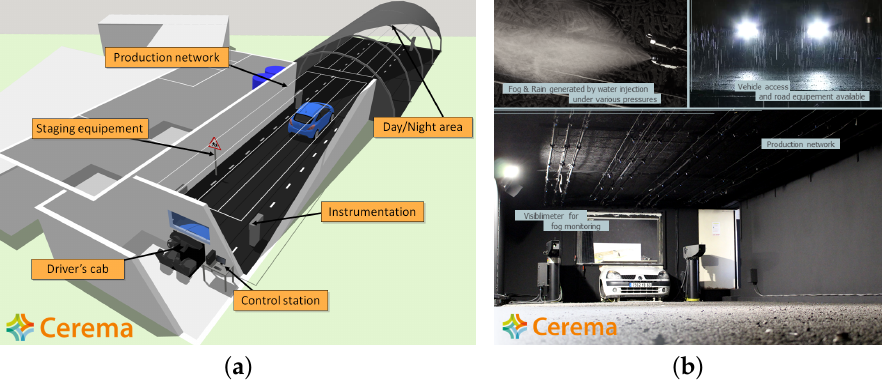
Figure 1. Cerema’s Adverse Weather platform [46]. ( a ) Overall structure. ( b ) Instruments and